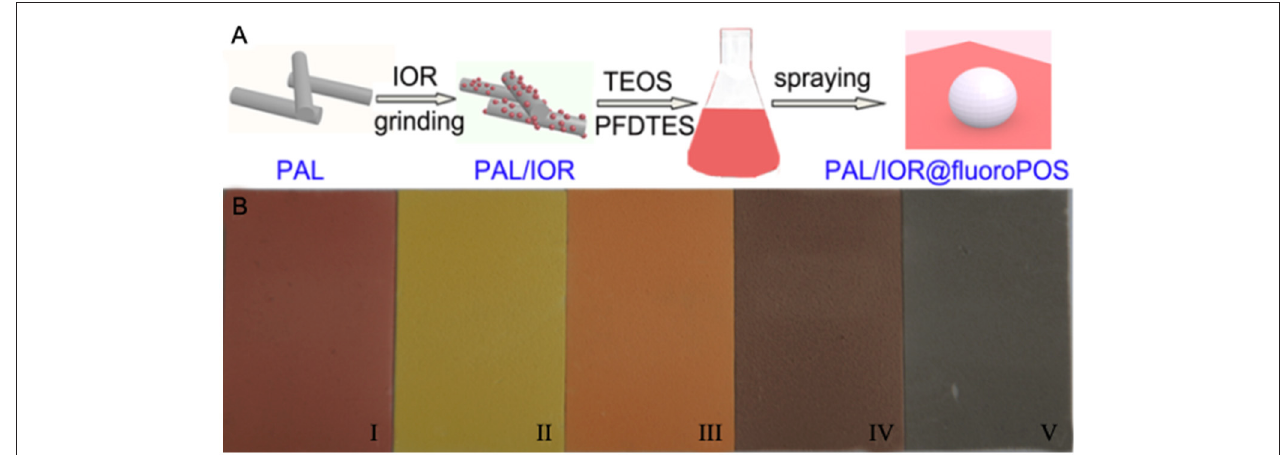
FIGURE 1 | (A) Preparation of the PAL/IOR@fluoroPOS superamphiphobic coatings, and (B) images of the coatings based on (i) IOR, (ii) IOY, (iii) IOO, (iv) IOBR and (v) IOBL on glass slides. C PAL / IOR = 14g L − 1 , t grinding = 20min, C PFDTES = 27.2mM, C TEOS = 4.5mM.